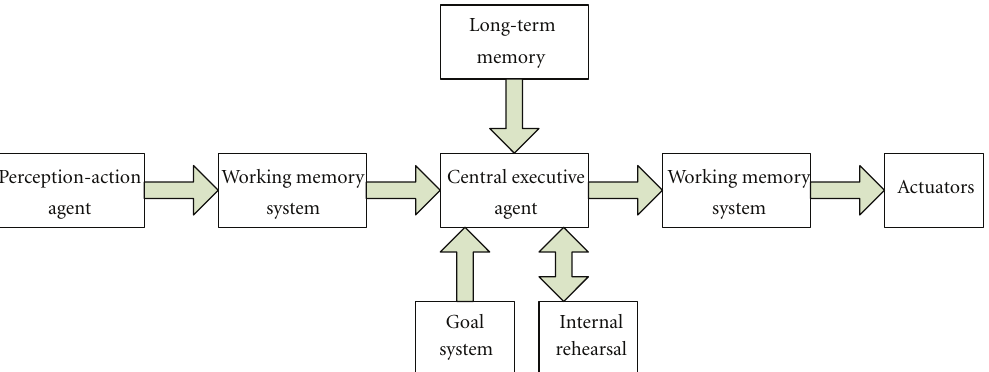
Figure 9: Work loop of the generation